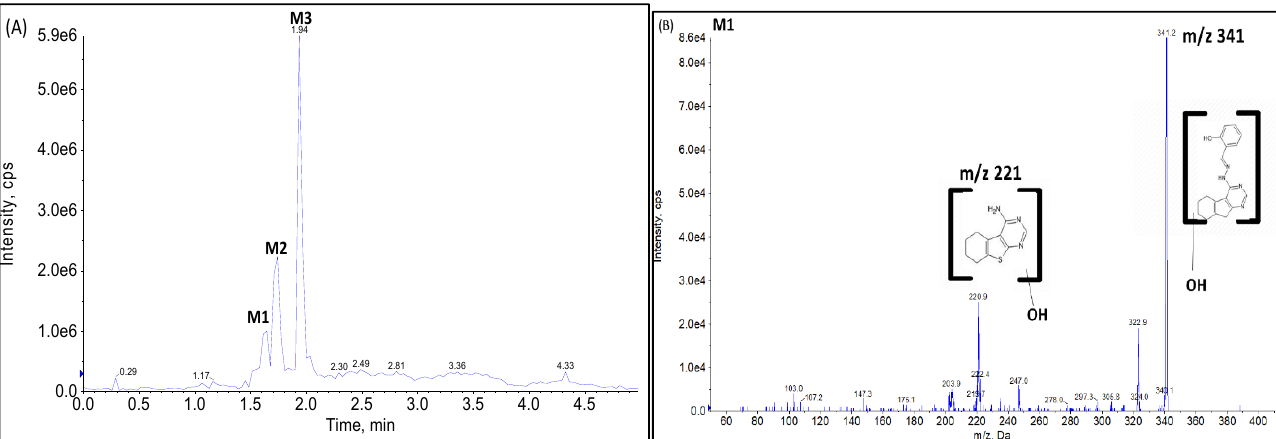
Figure 5. ( A ) Neutral loss of 136 Da chromatogram. ( B ) Spectra peak at 1.76 min (M2). ( C ) Spectra for peak at 1.96 min (M3). ( D ) Spectra for peak at 2.17 min (OJT007).